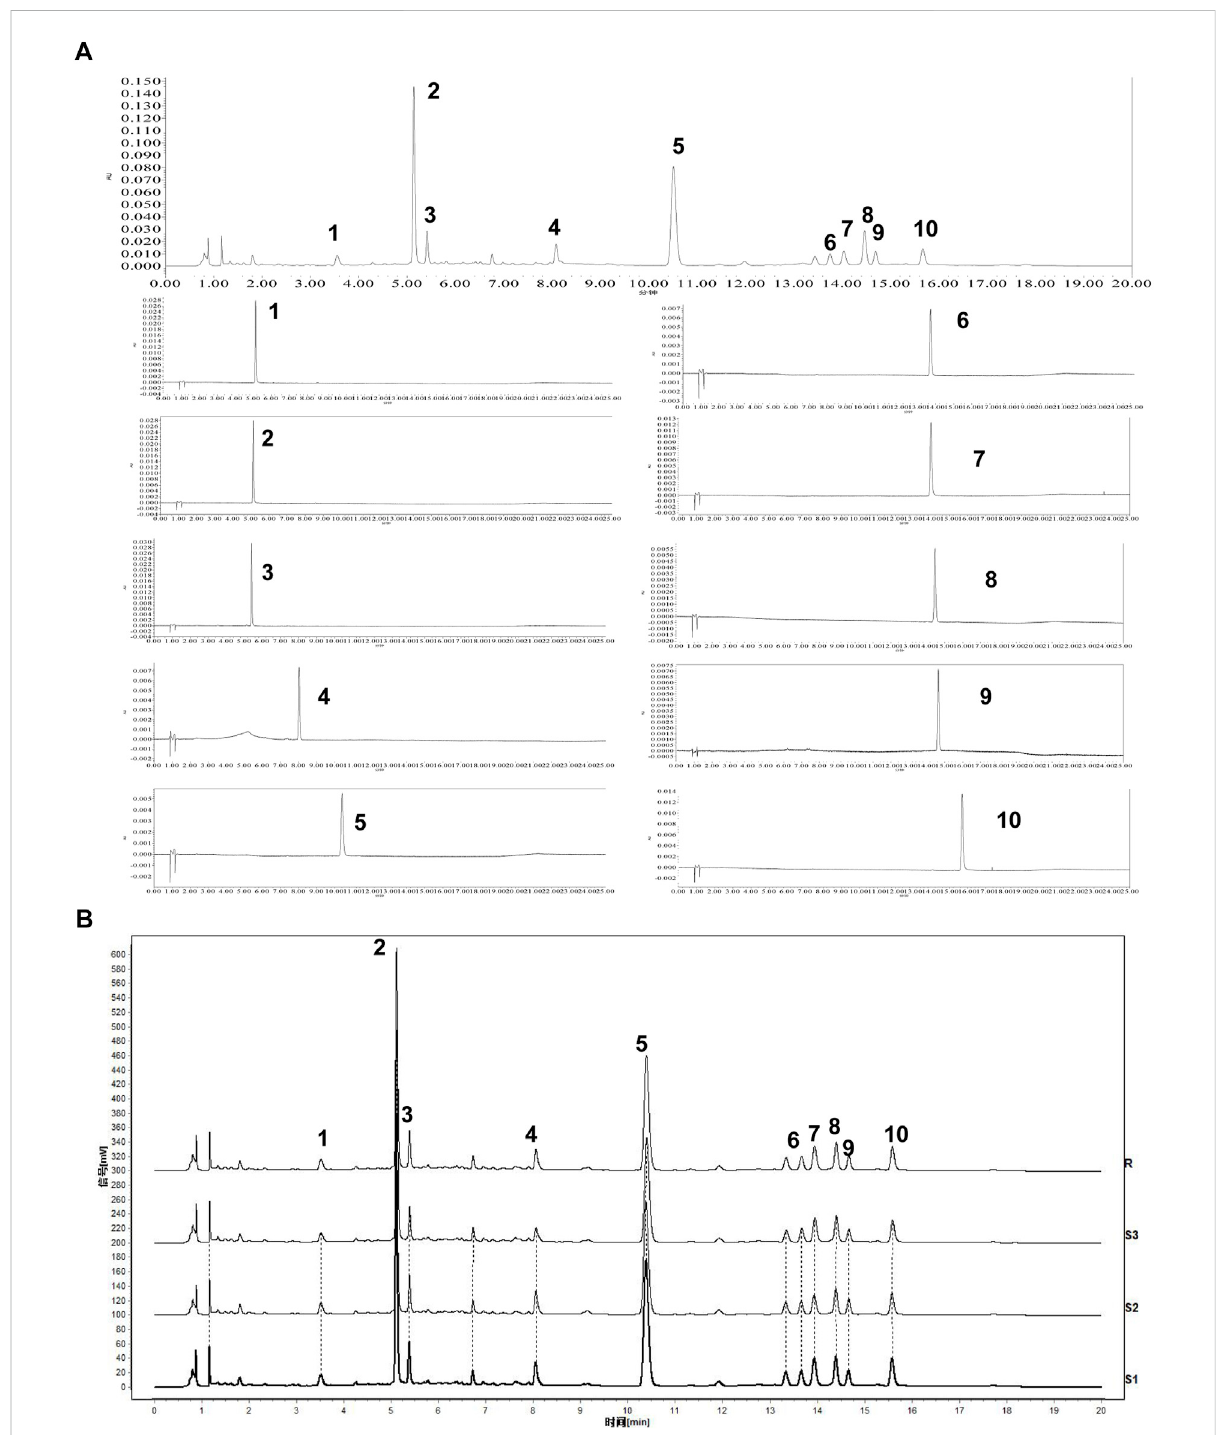
FIGURE 1 Analysis of the Main Components of AESS formula. (A) Typical UPLC chromatogram of the sample and 10 reference standards (1: Neochlorogenic acid, 2: Chlorogenic acid, 3: Cryptochlorogenic acid, 4: Prim- O -glucosylcimifugin, 5: Rutin, 6: Kaempferol-3- O -Rutinoside, 7: IsochlorogenicacidA,8:Narcissoside, 9:5- O -methylvisamitolglycoside. 10:IsochlorogenicacidC) (B) UPLCchromatographic fi ngerprintsofthree samples (S1-S3) and simulative median chromatogram